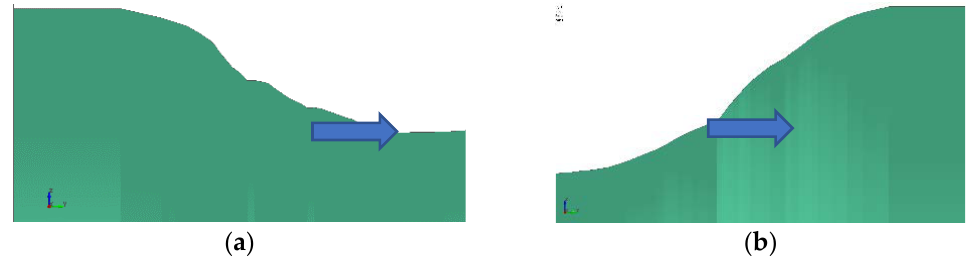
Figure 12. Schematic of the corroded surface profiles adopted in the simulations. ( a ) Inlet orifice; ( b ) Outlet orifice.